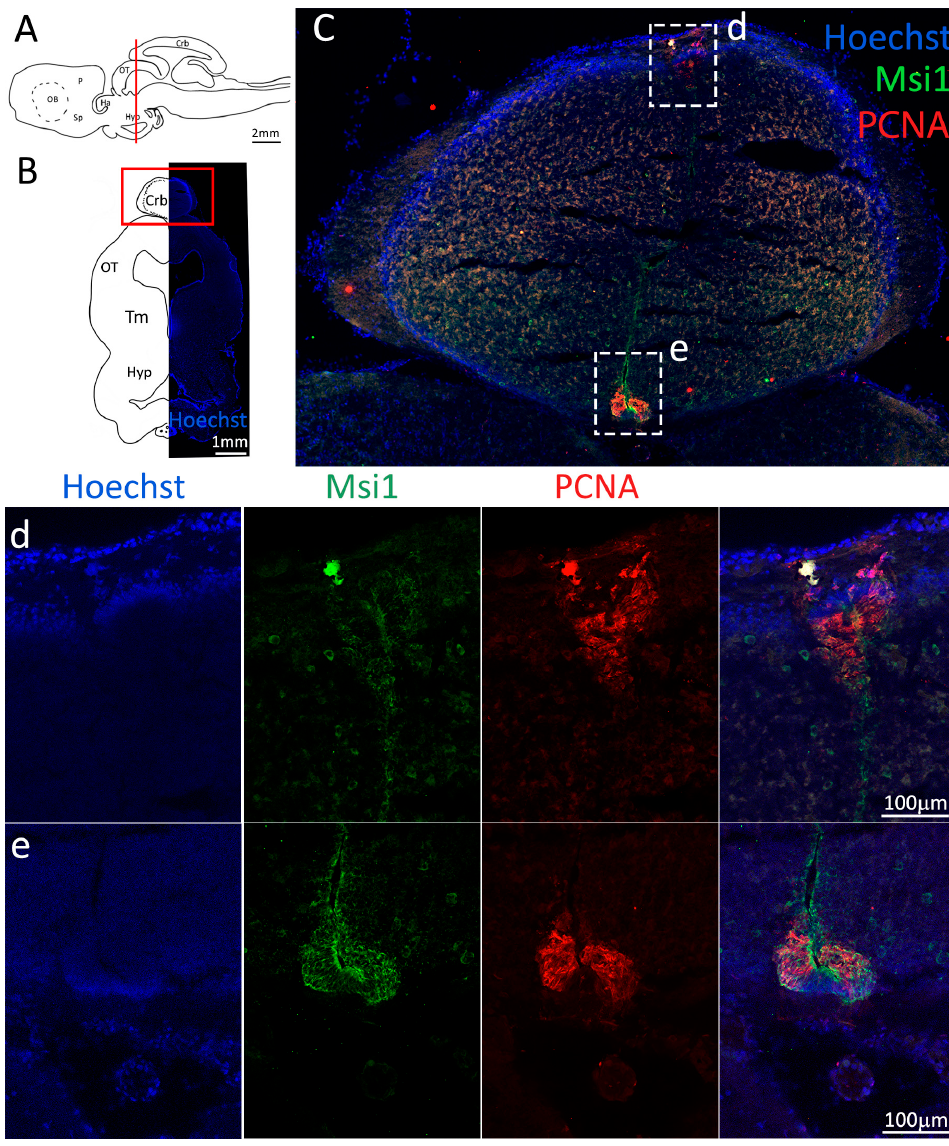
Figure 14. Localization of PCNA (red) and Msi1 (green) positive cells in the anterior cerebellum of S. canicula . ( A ) Sagittal representation of S. canicula brain. The red line indicates the rostro-caudal localization of the section represented in the panel. ( B ) Coronal map of the area imaged. On the right, a real coronal section is stained with Hoechst 33342 to show nuclei distribution; on the left, a cartoon is drawn to indicate anatomical references. Red rectangle identifies the general area from which images are taken. ( C ) Neurogenic niches of the anterior cerebellum. All PCNA + cells (red) appear to be Msi1 + , confirming their stem-cell nature. ( d ) Magnification of the neurogenic niche localized in the dorsal cerebellum. ( e ) Magnification of the neurogenic niche localized in the ventral